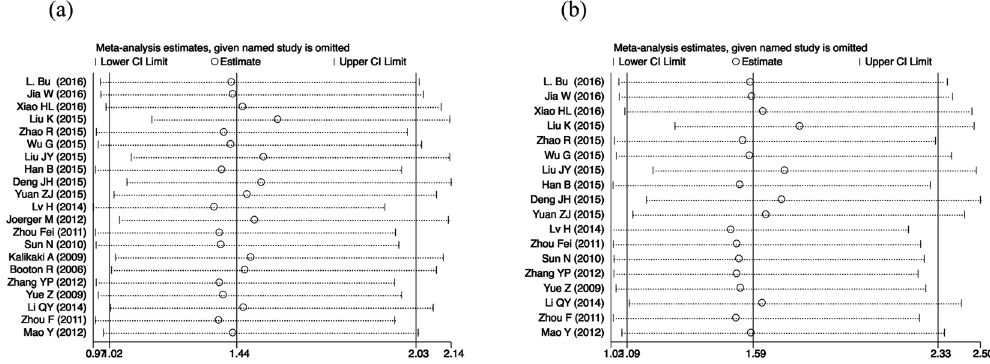
Figure 5. The sensitivity analysis of pooling ORs of ORR in NSCLC patients treated with platinum-based chemotherapy by the GSTP1 IIe105Val polymorphism (IIe/Val + Val/Val vs . IIe/IIe). ( a ) in overall patients, ( b ) in Asian